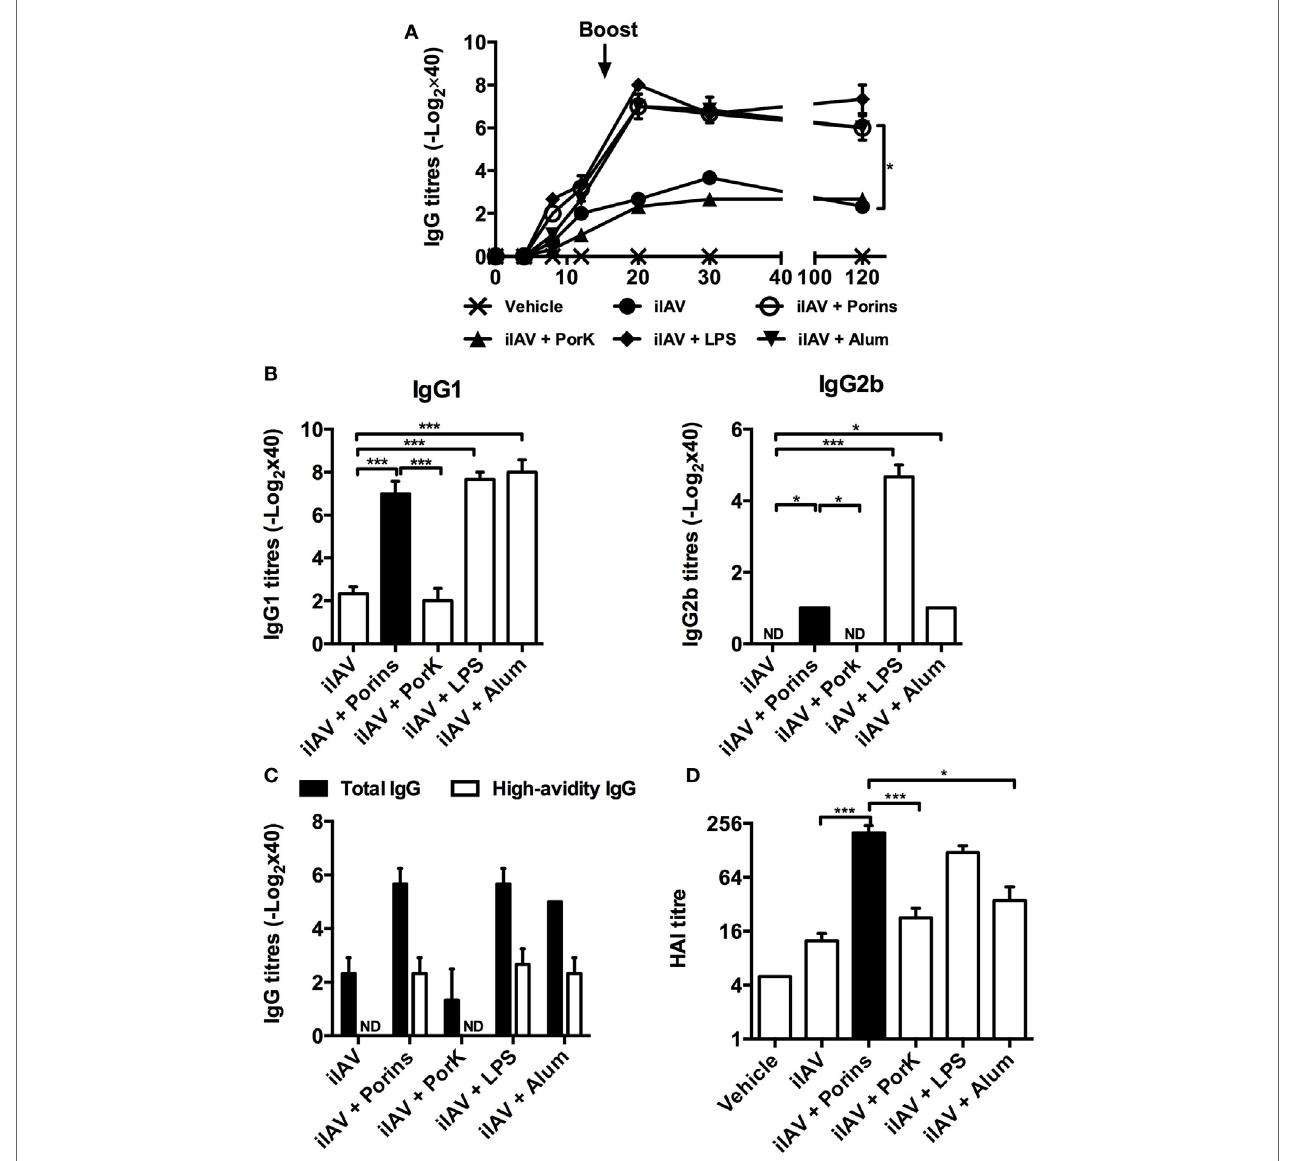
FigUre 3 | S. Typhi porins enhance functional antibody responses to an inactivated 2009 pandemic influenza vaccine . Four BALB/c mice per group were immunized i.p. with 4 HAU of a pandemic inactivated influenza A virus (iIAV), iIAV + 10 μ g of porins, iIAV + 10 μ g of PorK, iIAV + 5 μ g of LPS, or iIAV + 100 μ g of alum. (a) Serum IgG antibody responses were measured at the indicated time points. (B) IgG1 and IgG2b, high-avidity IgG titers (c) and HI titers (D) were measured 30 days post-immunization by ELISA. Mean + SEM are plotted. These data are representative of three independent experiments. Statistical analysis was performed using one-way ANOVA with Bonferroni test post hoc . For panel (a) , Student’s t -test was performed comparing only ovalbumin (OVA) versus OVA + porins groups. Statistical differences are depicted as * P < 0.05, ** P < 0.01, *** P <